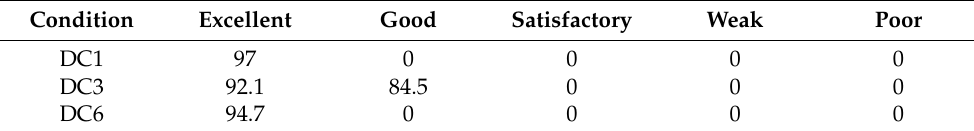
Table 7. The scoring matrix for part of the conditions of project 1. Condition